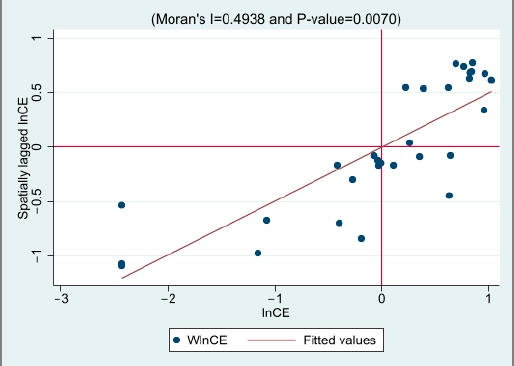
Figure 3. The scatter plot of the Moran index of CED in 2000.